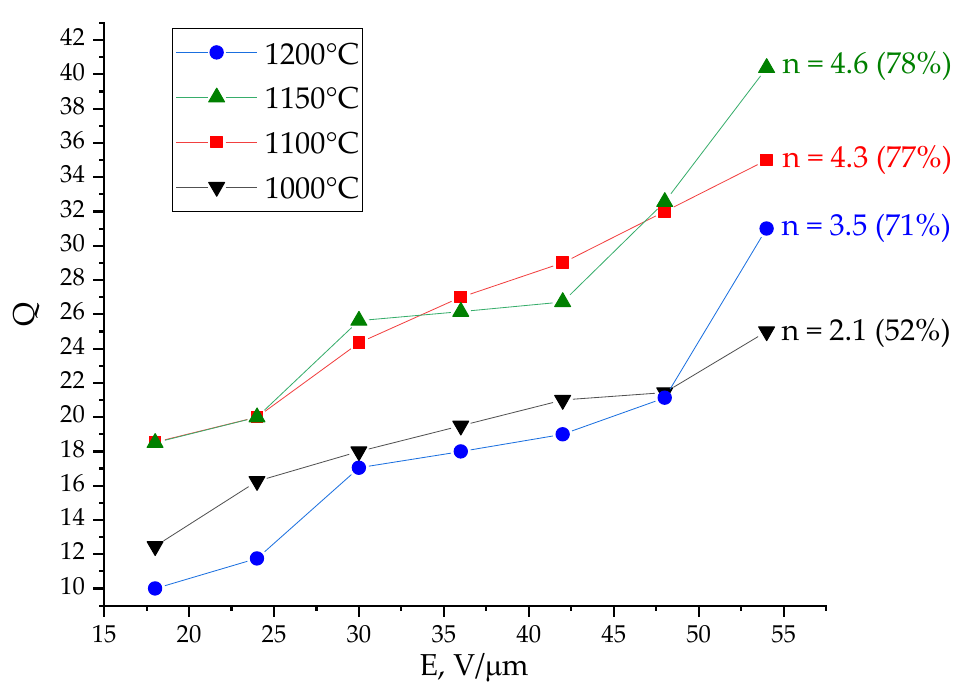
Figure 6. Voltage – capacitance characteristics of planar capacitors based on BZT films subjected to annealing at various temperatures.